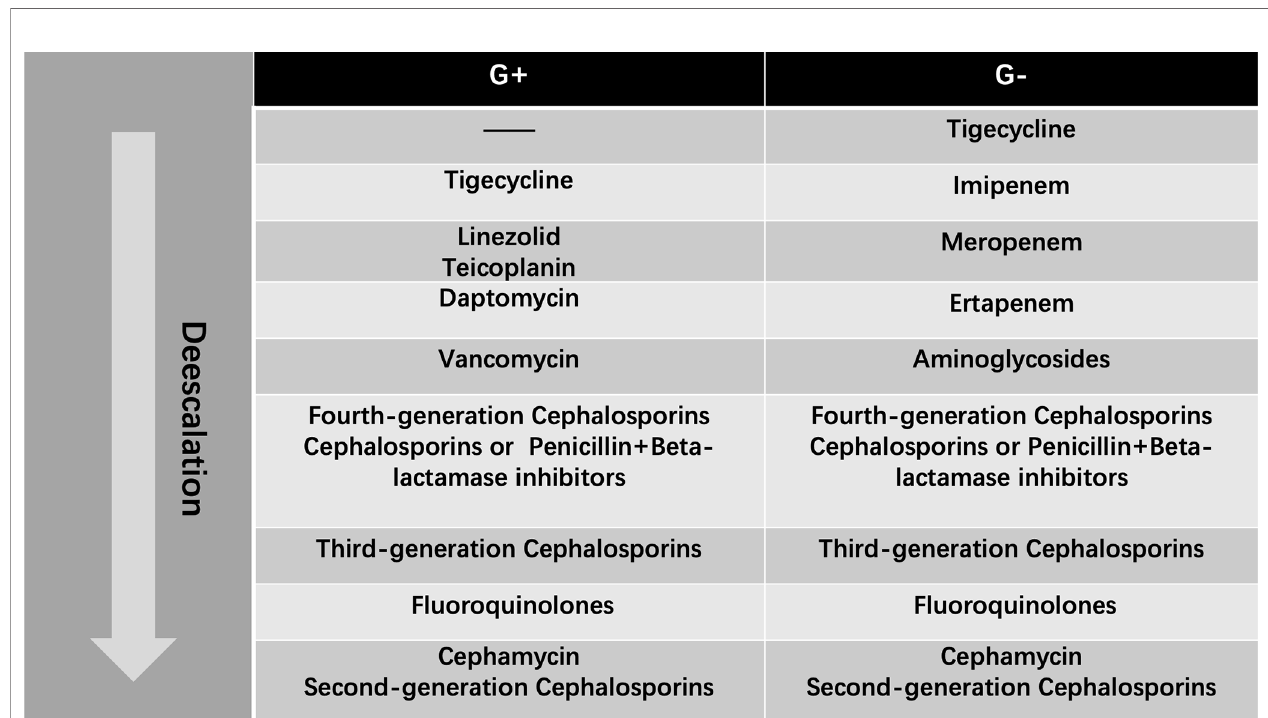
FIGURE 1 | Antibiotic Hierarchy from the Most-Broad-Spectrum (Top) to Least-Broad-Spectrum (Bottom) Antibiotic. G+: Gram-positive Organism Antibiotic Algorithm; G-: Gram-negative Organism Antibiotic